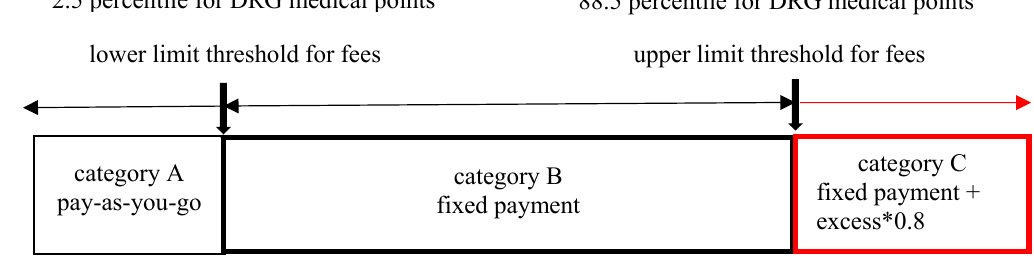
Figure 1. Taiwan diagnosis-related group (TW-DRG) payment system.